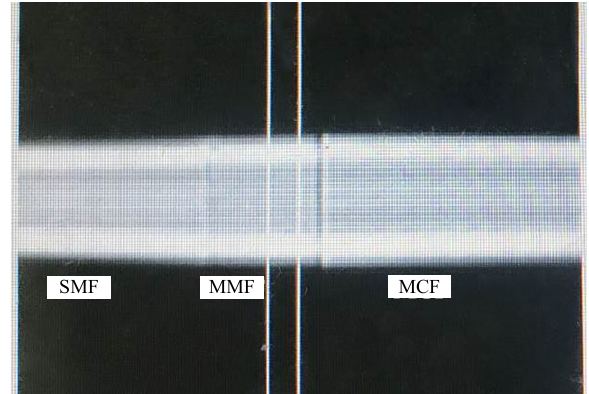
Fig. 6 Fiber cross section: (a) the 105/125 μ m MMF cross-section, (b) the TCF cross-section, and (c) the TCF electron microscope observation.